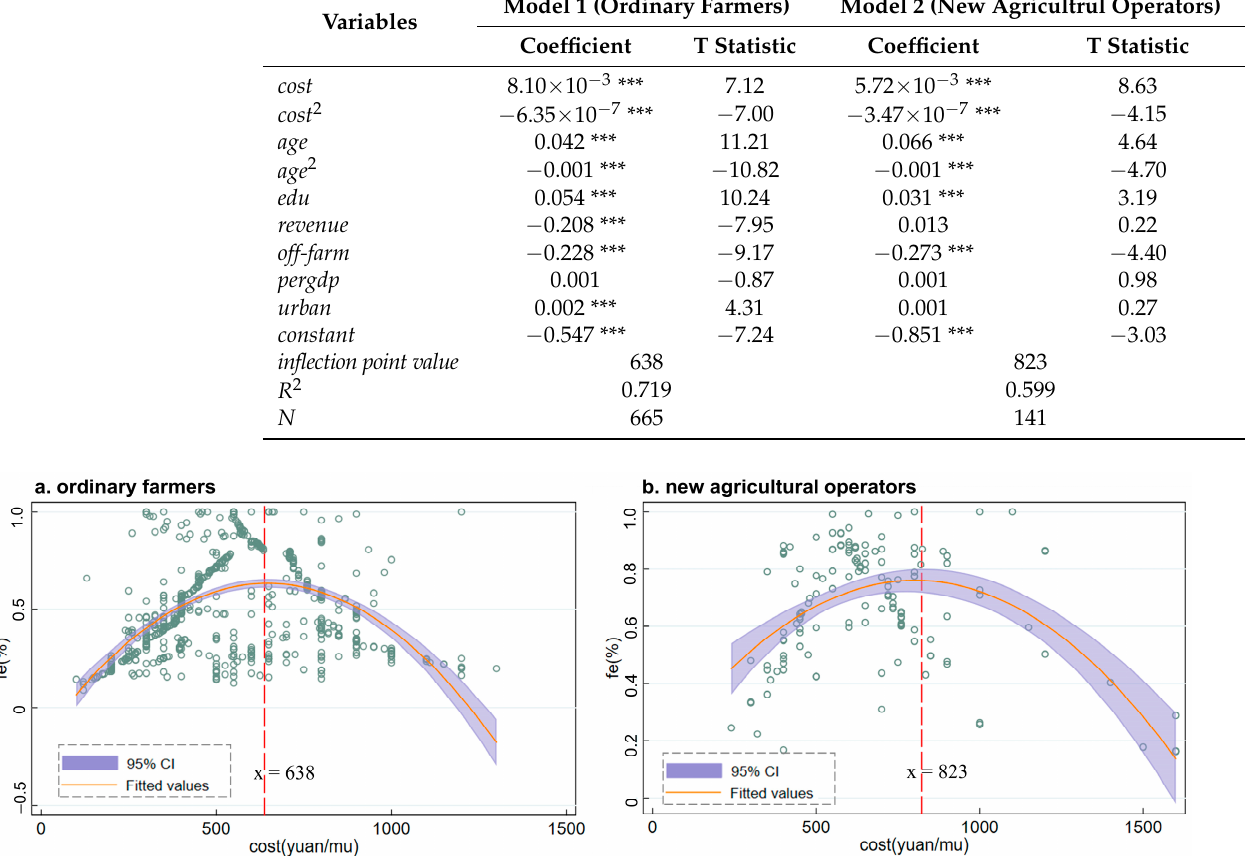
Figure 5. The scatter plots of cost and fe in ordinary farmers and new agricultural operators.